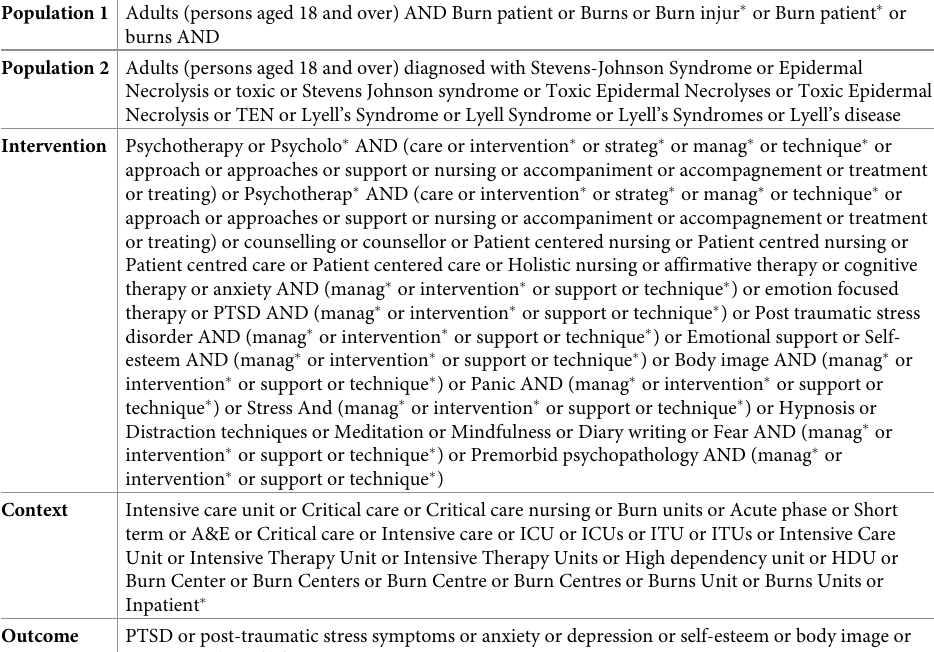
Table 1. PICO review question and search